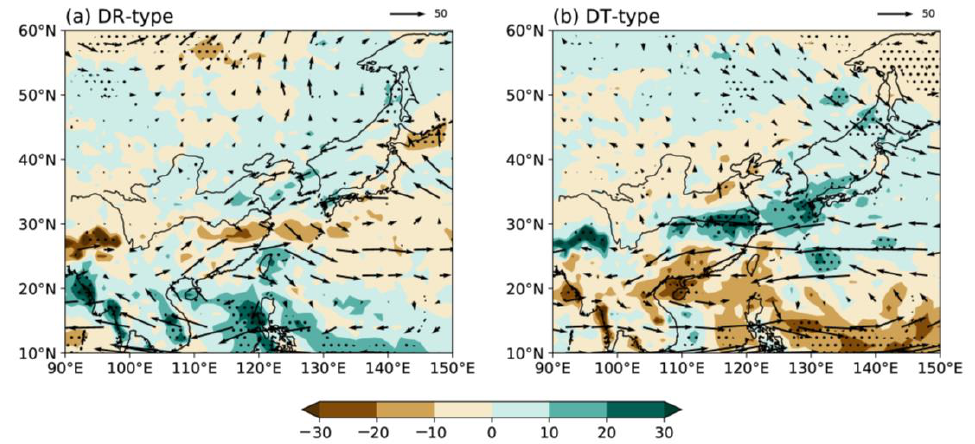
Figure 4. Composite summer vertical integral of moisture flux anomalies (vector, units: kg · m − 1 · s − 1 ) and its divergence anomalies (shading, units: 10 − 6 kg · m − 2 · s − 1 ) for ( a ) DR-type and ( b ) DT-type. The moisture flux divergence anomalies significant at the 90% confidence level are dotted.